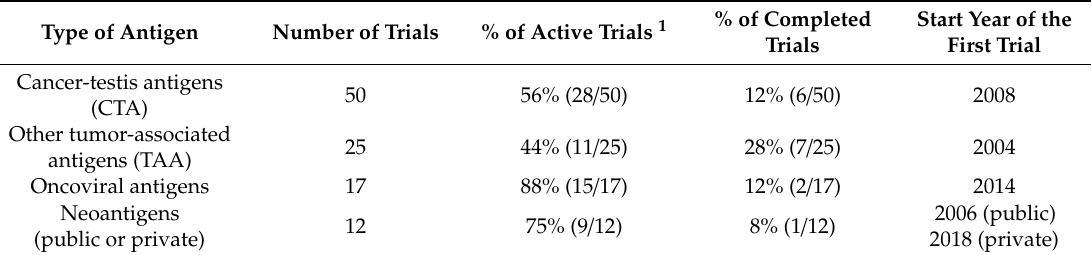
Table S1: TCR-T cancer clinical